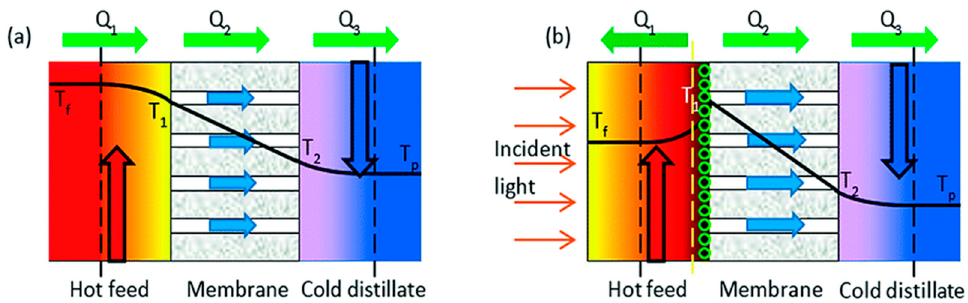
Figure 13. Schematic of ( a ) conventional DCMD and ( b ) novel photothermal DCMD with a nanomaterial coating and localized heating at the membrane surface. Reproduced from [86] with permission from The Royal Society of Chemistry.